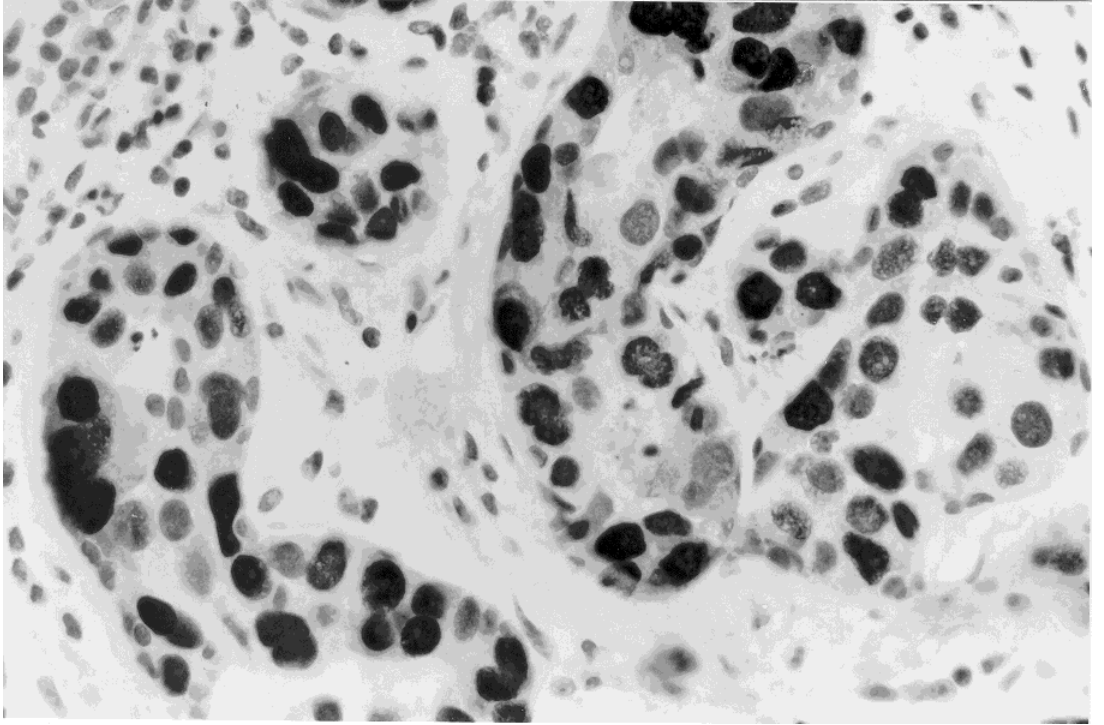
Fig. 1. Poorly differentiated adenocarcinoma of the breast showing strong nuclear immunoreactivity for P53 in most of the neoplastic cells (original magnification ×